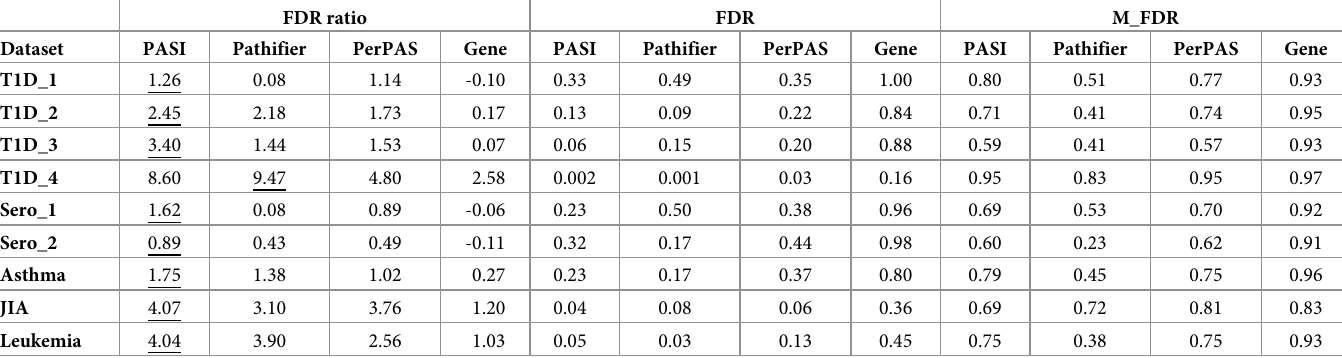
Table 2. Comparison of PASI, Pathifier and